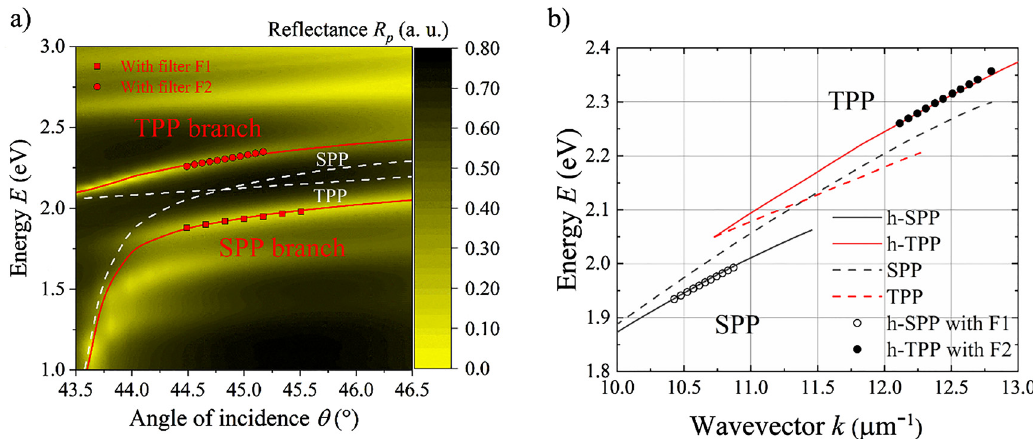
Figure 3: (a) The experimental dispersion relation of the hybrid TPP-SPP mode (red lines) with the calculated noncoupled single TPP and SPP modes(whitelines)andthe experimental resultsof thehybridmode withfilters incorporated intoanopticalscheme(squaresTPPbranchand circles SPP branch). (b) The dispersion relation of the hybrid TPP-SPP mode (solid lines), the h-TPP, h-SPP with filters F1, F2 (circles) and the dispersion of the uncoupled single plasmonic TPP and SPP modes (dashed